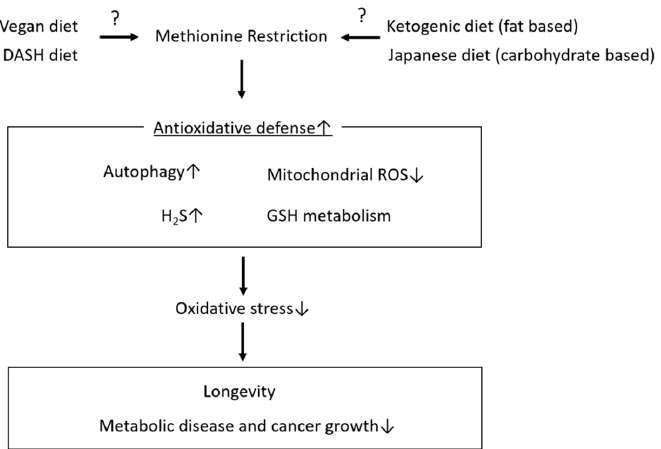
Figure 3. Effect of methionine restriction on longevity and age-related pathologies. Methionine restriction may be one of the dietary interventions involved in longevity and the amelioration of age-related pathologies, including metabolic disease and cancer growth, partially through the enhancement of antioxidative defenses and attenuation of oxidative stress. Several diet patterns, such as the vegan diet, the DASH diet, ketogenic diet (fat based) and Japanese diet (carbohydrate based), may be candidates for a dietary pattern that restricts methionine intake. ↑ : upregulation, ↓ : downregulation.